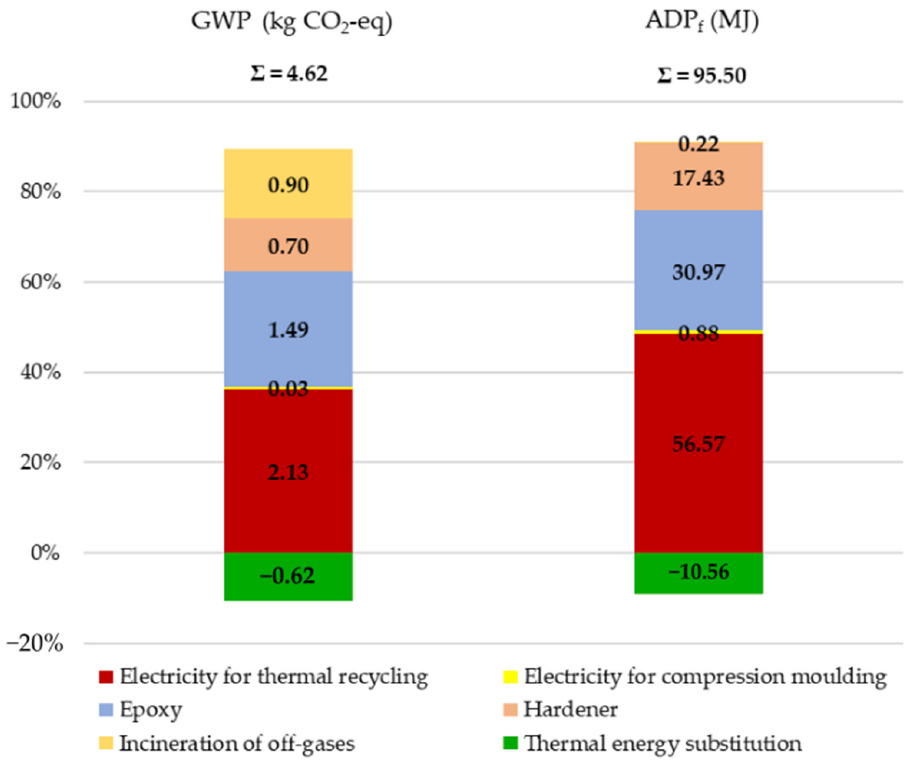
Figure 5. GWP and ADP f results for producing 1 kg of rGFRP